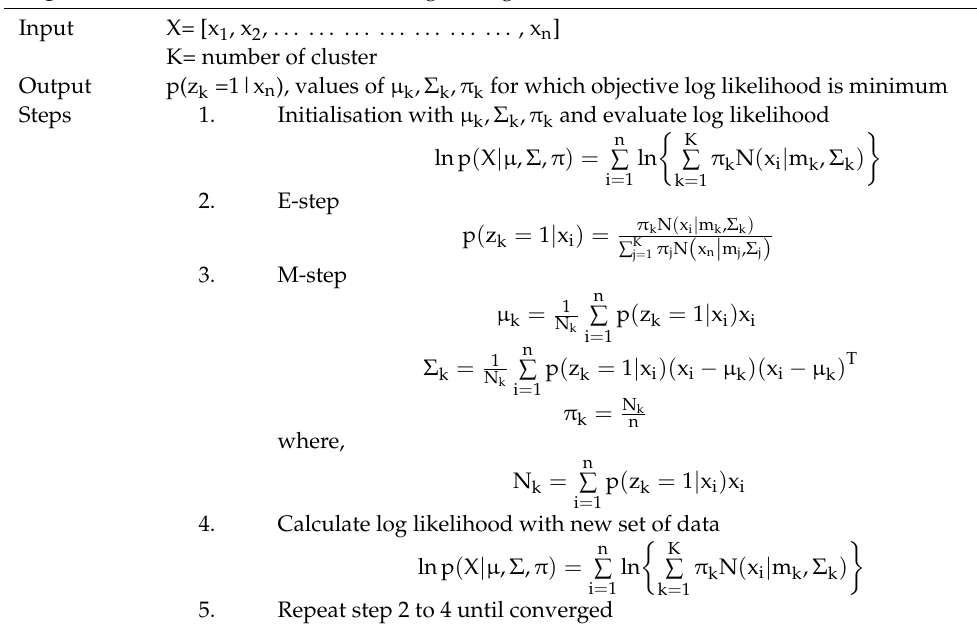
Algorithm 3: Gaussian mixture modelling EM